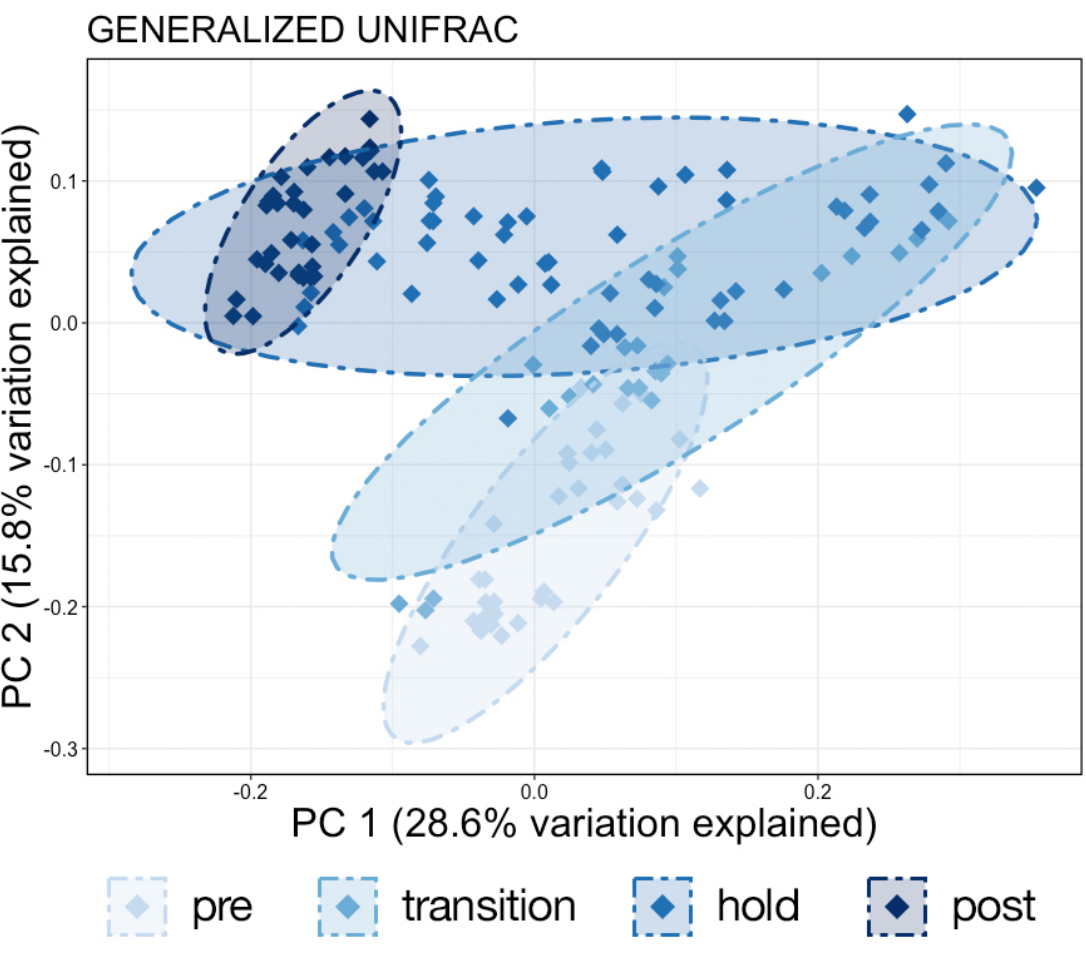
Figure 4. PCoA of the microbial communities from water samples throughout the water change. To aid visualization, samples are colored by phase (pre n = 33, transition n = 42, hold n = 59, post n = 33) opposed to salinity. All phases were significantly different from each other (PERMANOVA with Benjamini–Hochberg correction, n = 33–59, p < 0.05).